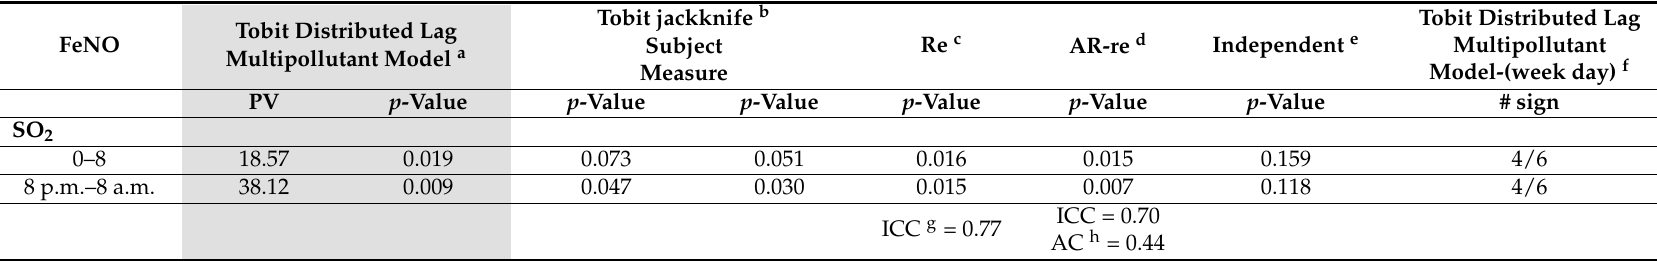
Tobit Distributed Lag Multipollutant Model-(week day) f